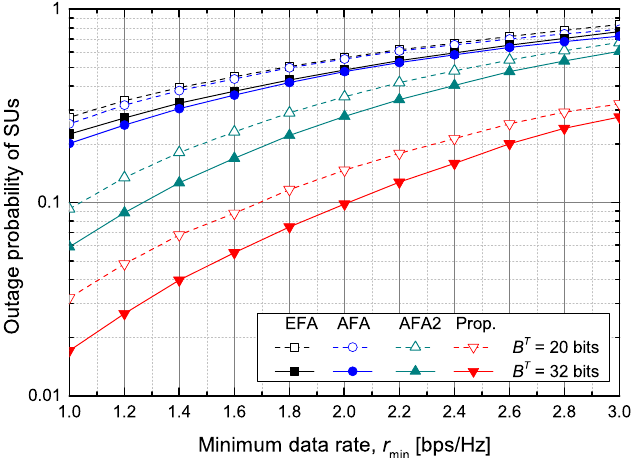
Figure 8. The outage probability versus the minimum data rate.